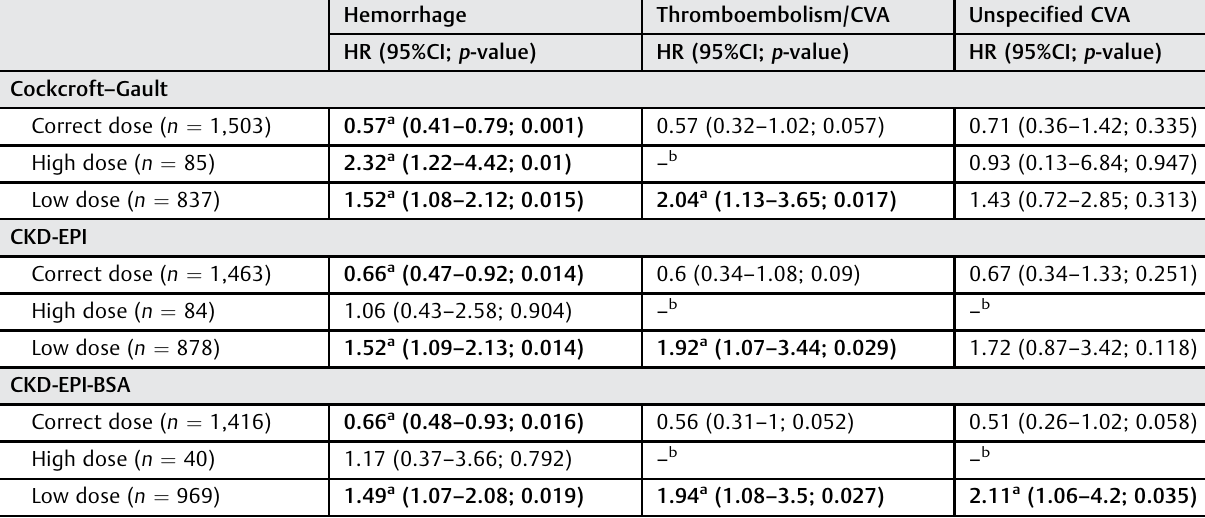
Table 4 Estimated hazard ratio (HR) and 95% con fi dence interval (95% CI) of hemorrhage, thromboembolism/CVA, or unspeci fi ed CVA, by actual dose dispensed compared with renal function estimator